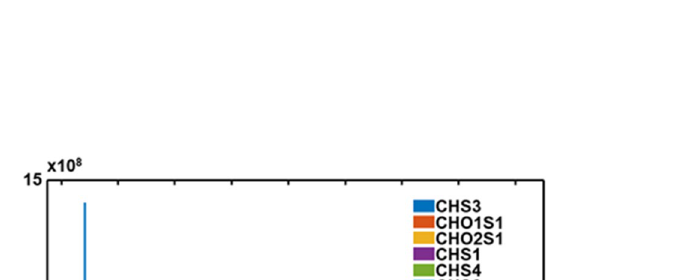
Figure 2. ( A ) Temperature-resolved mass loss and differential mass loss curves normalized to the 15 mg input weight Murchison IOM. ( B ) Temperature-response of the individual compound classes of Murchison IOM organic footprint. The inset reflects the proportions of the three dominant classes pure hydrocarbons (13%, CH), oxygenated organics (68%, CHO x ) and Sulphur-species (4%, CHS x ). Other classes, mainly oxygenated Sulphur- species, are summed up and given as rest with 15%.